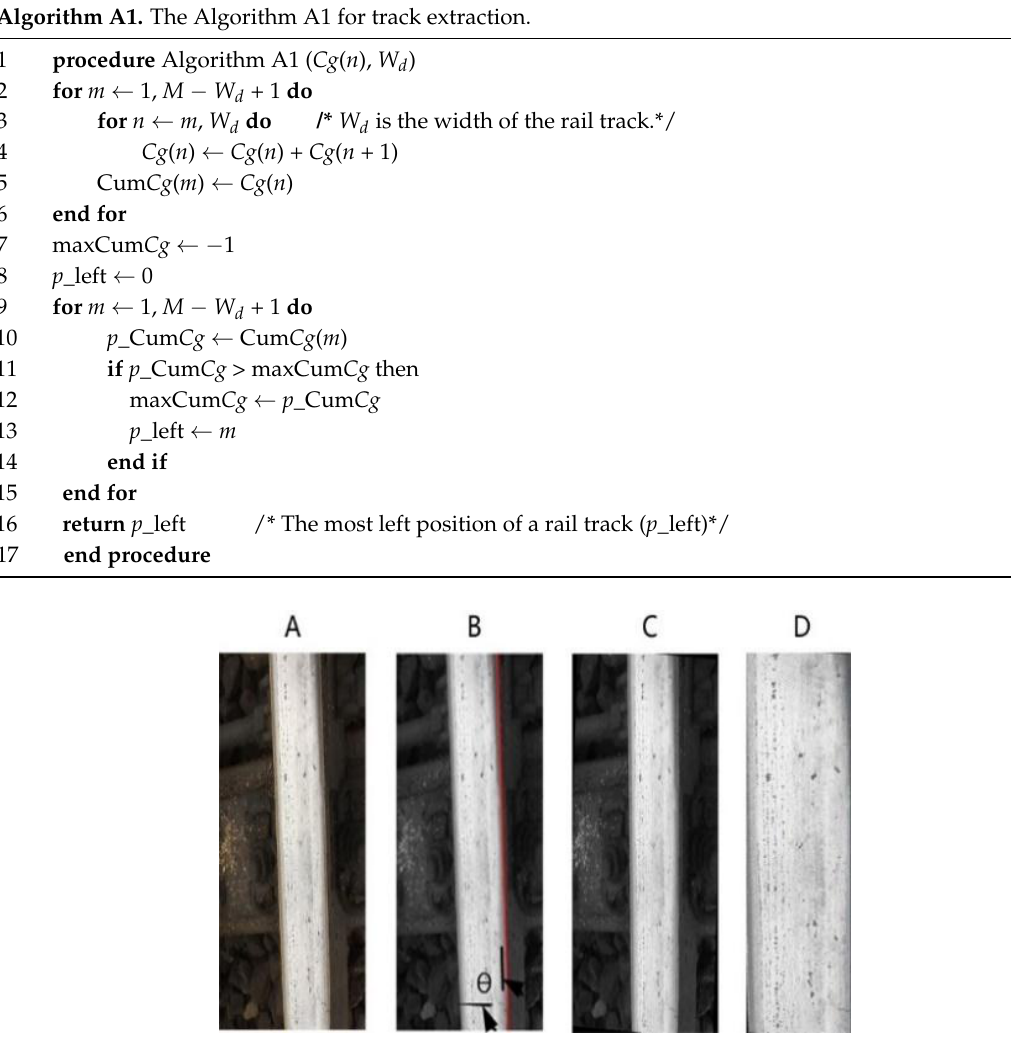
Figure A1. The example of the rail track extraction. ( A ) The original image contains a rail. ( B ) The detection for the longest line and the inclined angle ϴ of the rail based on Hough transform method. ( C ) The rail image correction by rotating the angle ϴ . ( D ) The rail track extraction based on integral projection of vertical pixel column for a rail image.